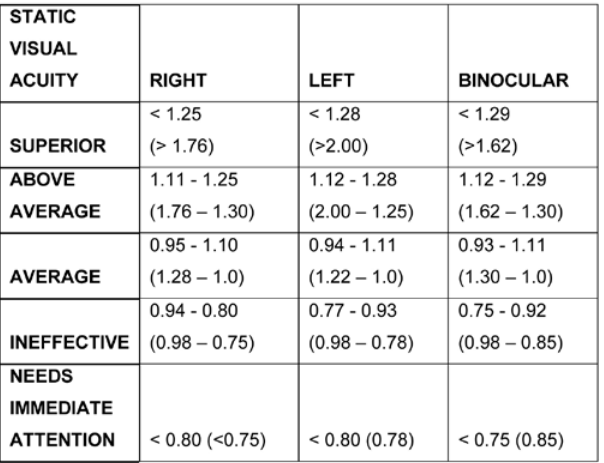
Table 1: The norms for static visual acuity (decimal notation) are indicated. (A Snellen VA chart was used at three metres and results were converted to visual acuities at six metres.) The re- sults in brackets are the results obtained by Buys4.